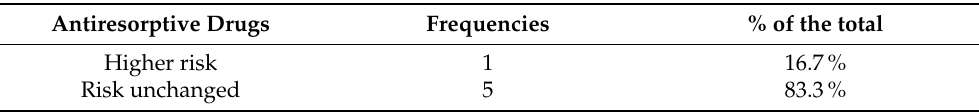
Table 6. Articles grouped by findings concerning the use of antiresorptive drugs as a risk factor for biological complications of dental